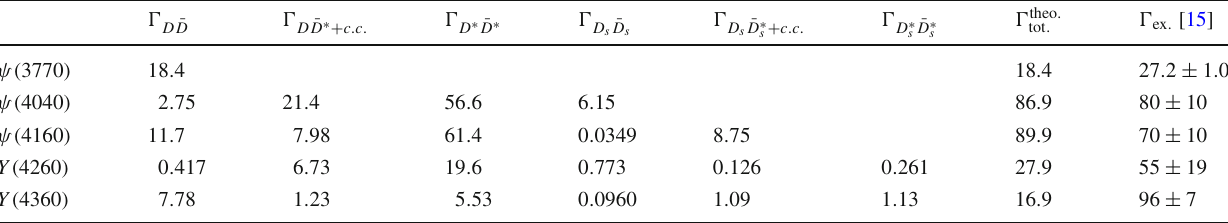
Table 3 Decay widths of D ( ∗ ) ¯ D ( ∗ ) , D ( ∗ ) s ¯ D ( ∗ ) s channels for states above the open-charm threshold in the unit of MeV. (cid:8) theo . ( ∗ ) ¯ D ( ∗ ) of those in D ( ∗ ) ¯ D ( ∗ ) , D s s channels which are allowed by energy conservation